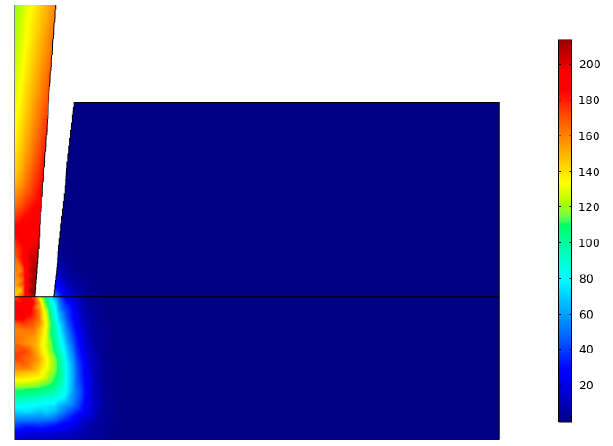
Figure 9. Shear stress distribution (Pa) at 37 °C.